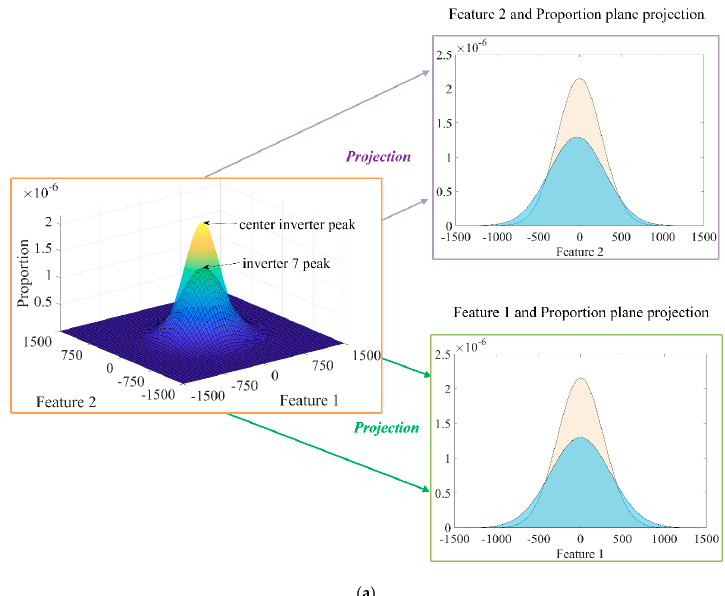
Figure 11. Prognostics radar charts of inverters in different periods: ( a ) inverters in May 2017; ( b ) inverters in November 2017; ( c ) inverters in January 2018; ( d ) inverters in April 2018. In order to better observe the divergence of the Gaussian mixture model in January 2018 and April 2018 for inverter 7, we plotted the feature distribution projections of inverter 7 in these 2 months.